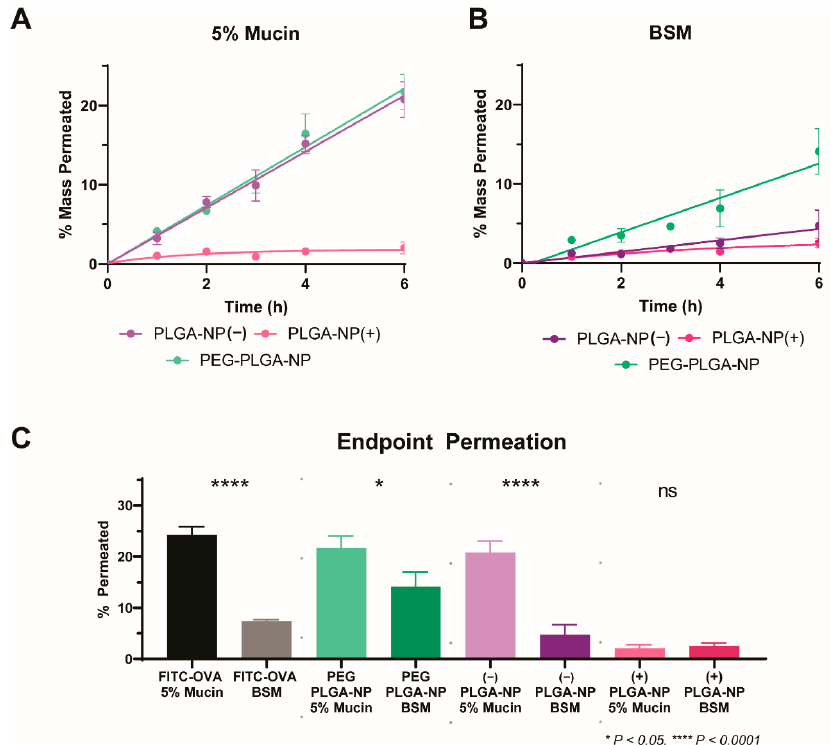
Figure 4. Charge-dependent permeation of PLGA nanoparticles through 5% mucin ( A ) and BSM ( B ). Comparative permeation of all particles and all mucus mimics at 6 h ( C ). All analyses were collected via fluorescent signal of encapsulated FITC-OVA. Non-significant data is designated ‘ns’.